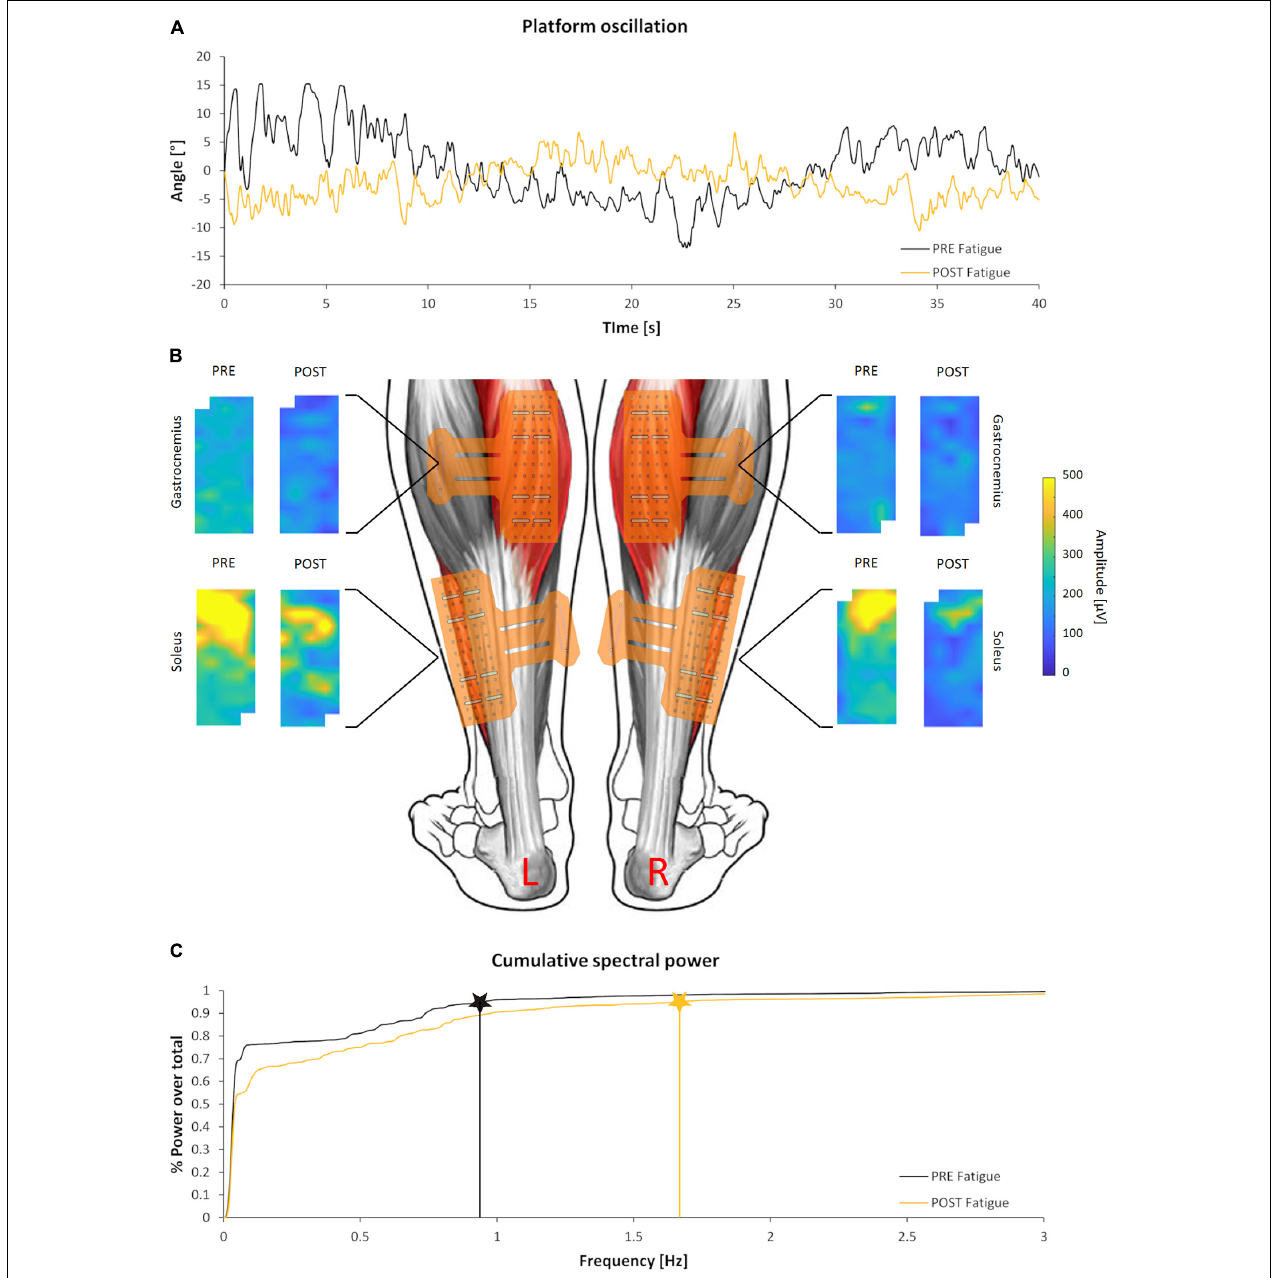
FIGURE 2 | Kinematics and electromyographical (EMG) outcomes of a representative subject. (A) Angular displacement signal of the oscillating platform before (black) and after (yellow) the fatigue protocol. (B) Colored maps representing the spatial distribution of EMG activity before and after the fatigue protocol of the calf muscles analyzed. Maps are scaled to the same amplitude to highlight the differences between and within muscles. (C) Integral of the PSD time-angle curve and correspondent PSD_95% values before (black) and after (yellow) the fatigue